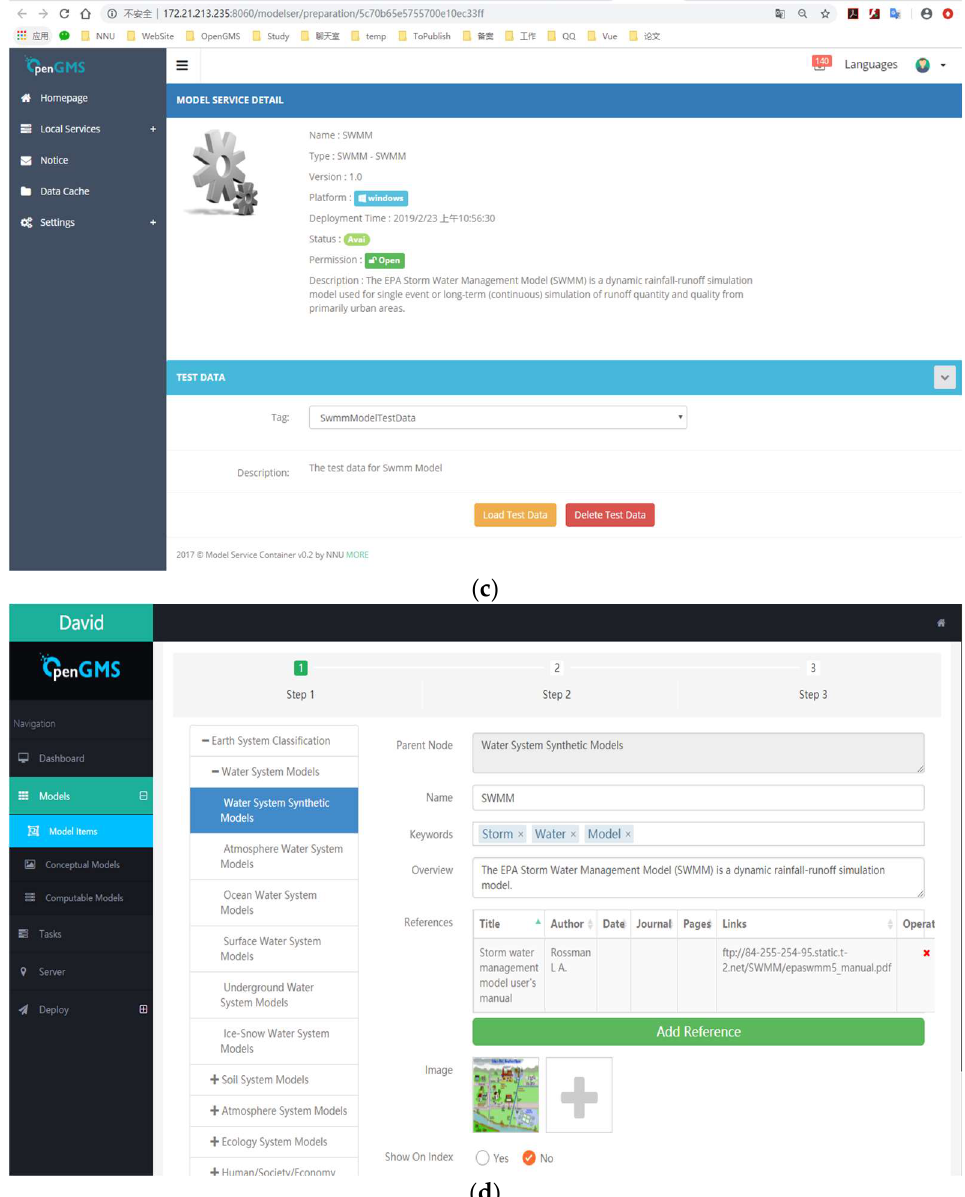
Figure 8. SWMM deployment and service publishing. (a) The matching of software and hardware environment. (b) Publishing SWMM model package as a service. (c) The state in which SWMM model service can be called. (d) Creating the SWMM model item.